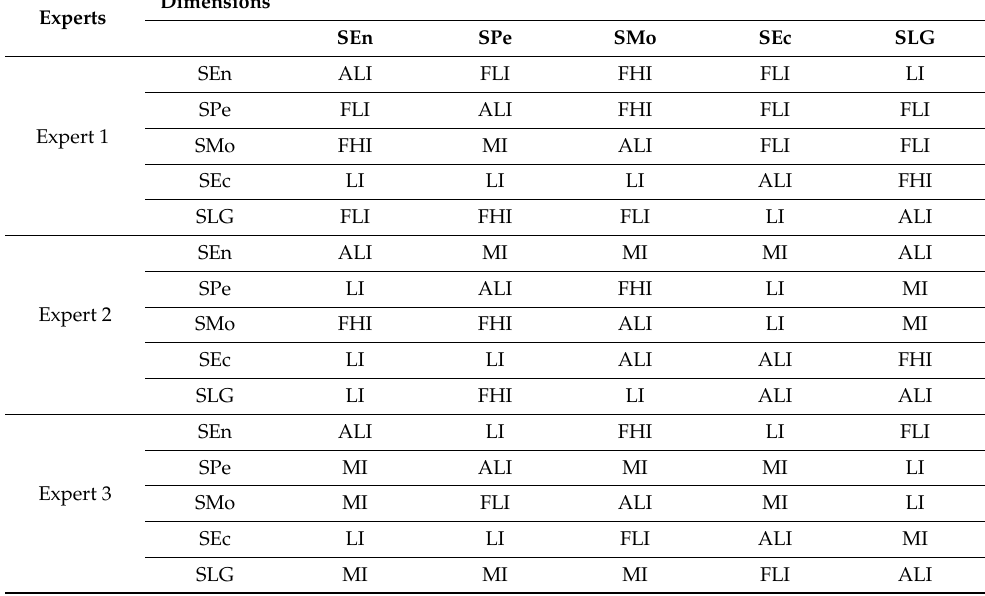
Table A2. The judgments of experts for the principal dimensions by using linguistic